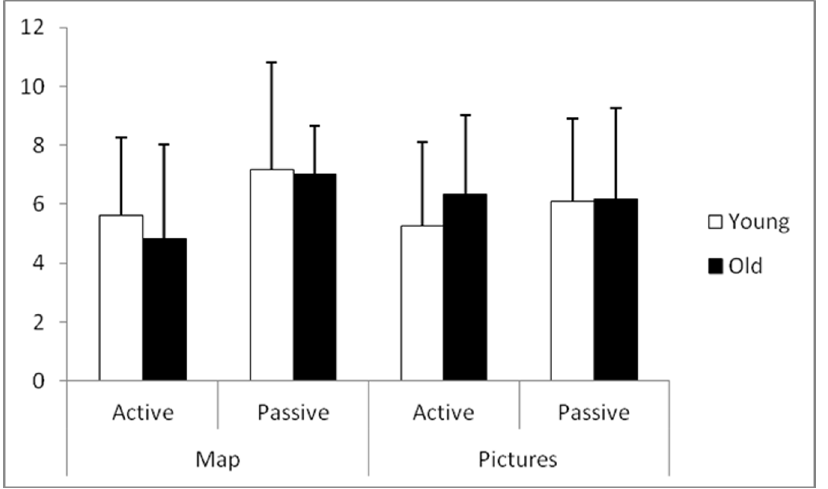
Figure 3. Spatial memory performances as a function of age and the navigation condition. Mean and Standard-deviation for the sketch drawing scores and the picture classification scores, according to the active and passive learning conditions and age; ANOVA (Group x Exploration) results.